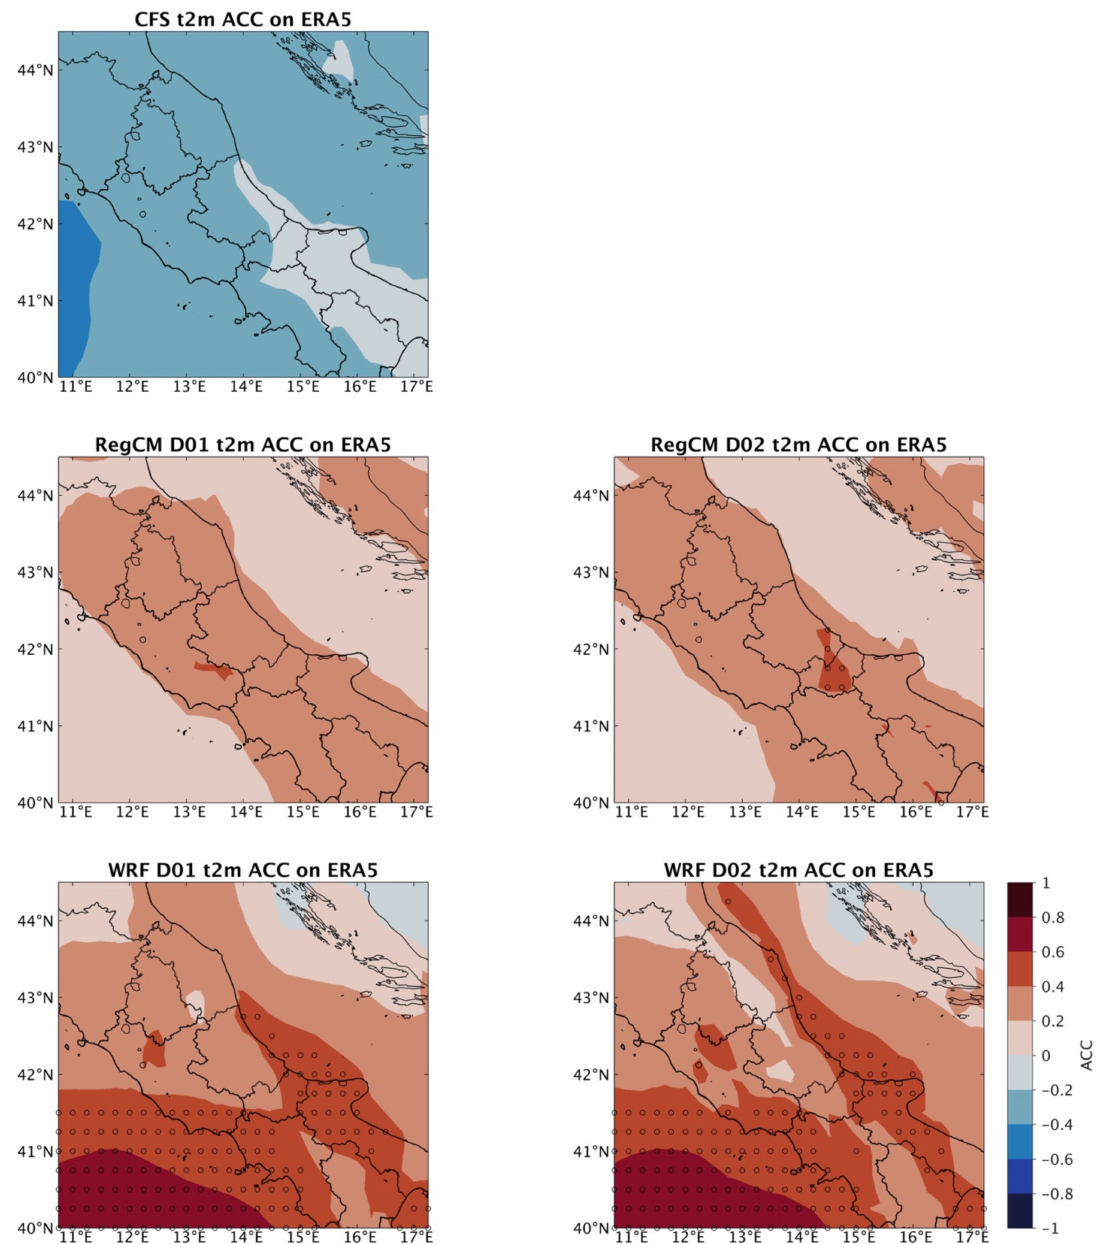
Figure 5. Anomaly Correlation Coefficients (ACCs) for CFS upper panel, RegCM (D01 and D02) central panels and WRF (D01 and D02) bottom